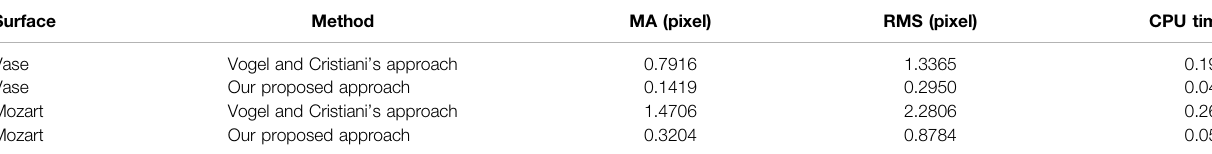
TABLE 1 | Comparisons of approaches for Vase and Mozart surfaces. Surface